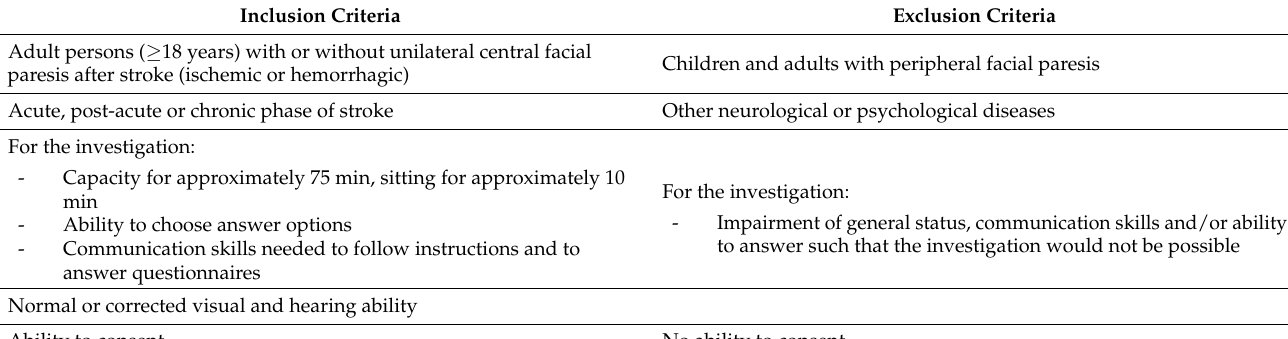
Table 1. Inclusion and exclusion